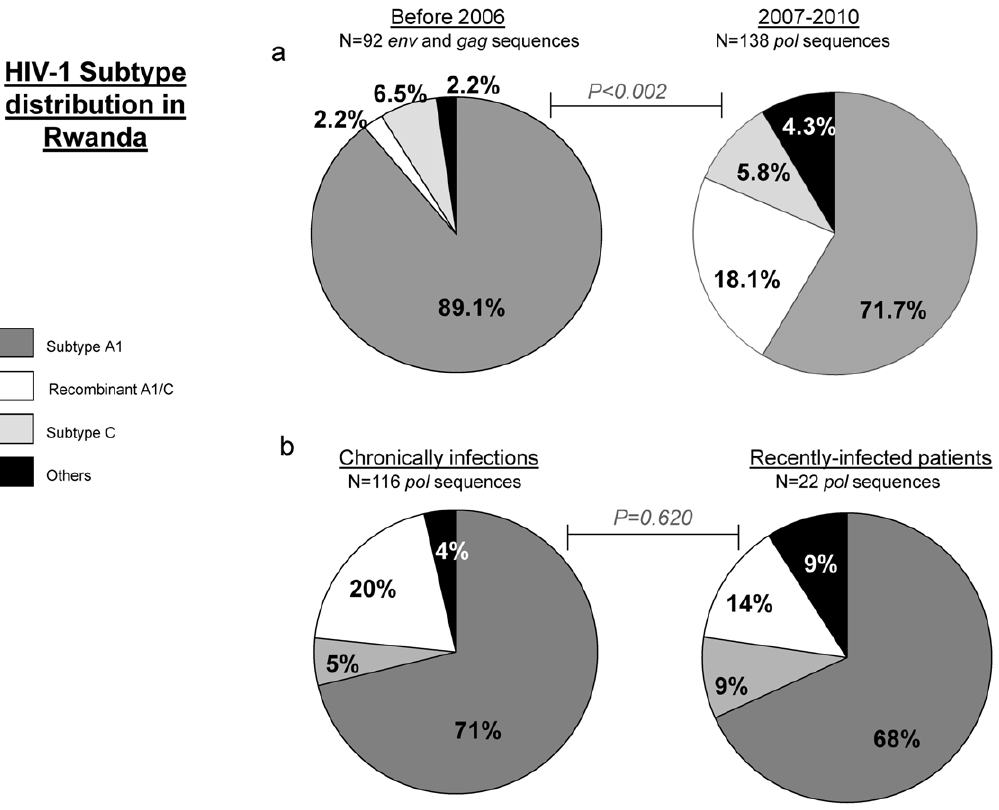
Figure 3. HIV-1 subtype distribution in Rwanda. a) The pie chart on the left shows the HIV-1 subtype distribution of 92 gag and env sequences isolated between 1988 and 2006 in Rwanda and available from the Los Alamos database. The classification of subtype A into the A1 sub-subtype was not routinely done before 2006. The pie chart on the right shows the HIV-1 subtype distribution of 138 pol sequences from the chronically and recently infected study participants enrolled between 2007 and 2010. The HIV-1 subtype distribution before 2006 and in our cohort was significantly different as calculated by the Pearson Chi square (p , 0.002). b) Subtype distribution in chronically infected study participants (on the left) and recently (on the right) infected participants enrolled in our study between 2007 and 2010. No statistically significant differences in the subtype distribution were found.